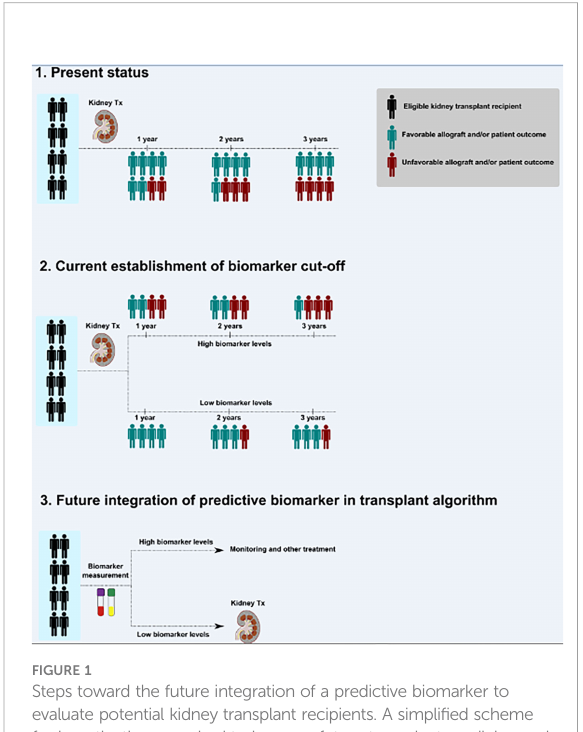
FIGURE 1 Steps toward the future integration of a predictive biomarker to evaluate potential kidney transplant recipients. A simpli fi ed scheme for investigations required to improve future transplant medicine